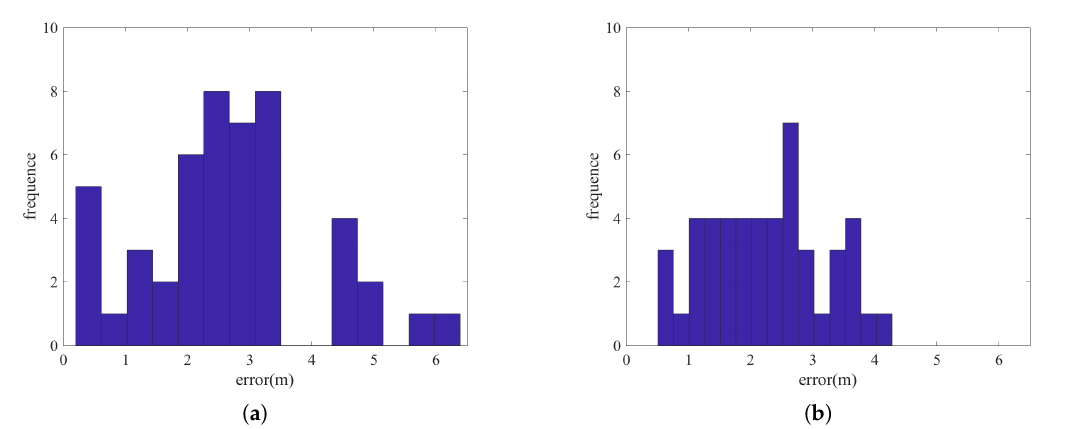
Figure 9. The histogram of beacon positions errors for sparse beacons situation ( a ) Cost function with PDR constraint error terms and beacon position constraint error terms ( b ) Cost function with PDR constraint error terms, beacon position constraint error terms and fingerprint matching constraint error